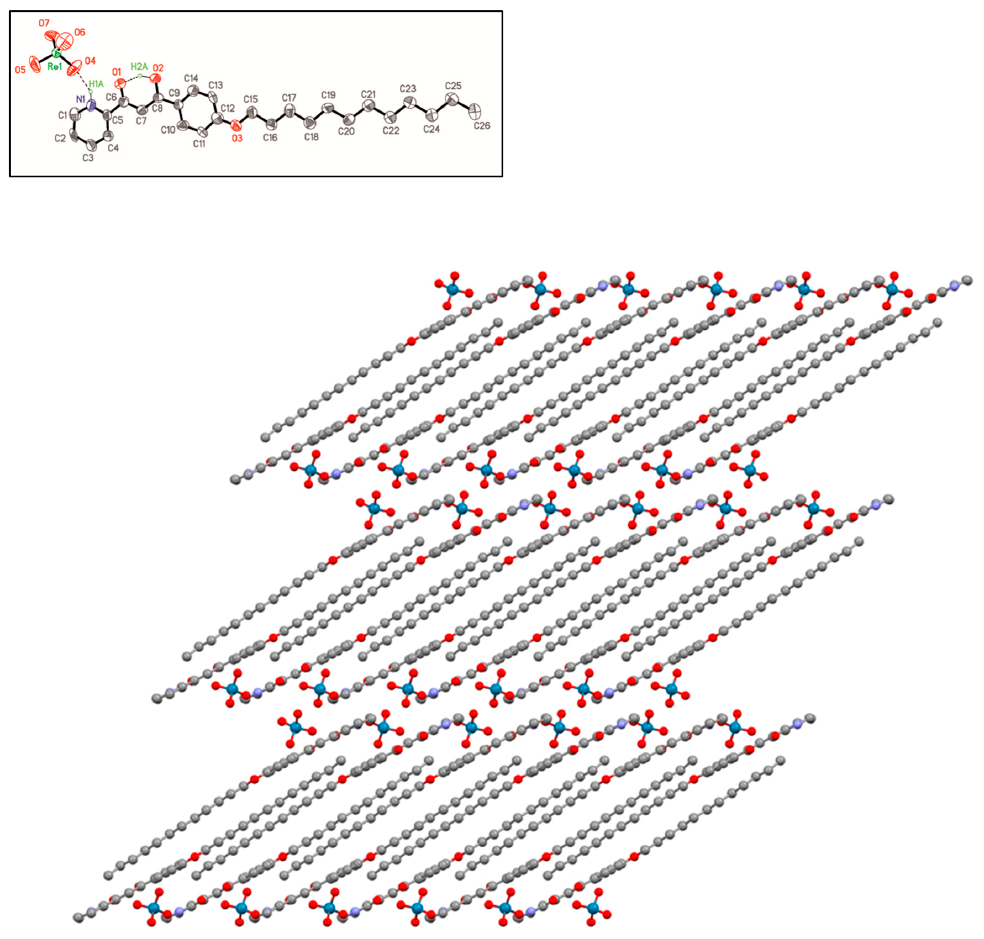
Figure 1. Crystal structure of [HOO R(12)pyH ][ReO 4 ] ( 5 ): Layer-type distribution showing interdigitated chains. The inset shows the ORTEP plot with 40% probability.